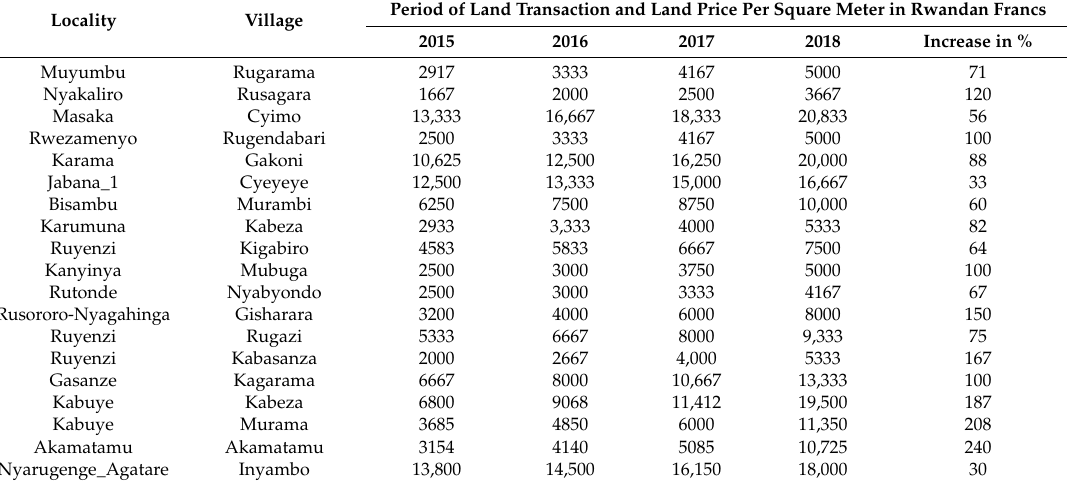
Table A4. Variation in land prices from 2015 to